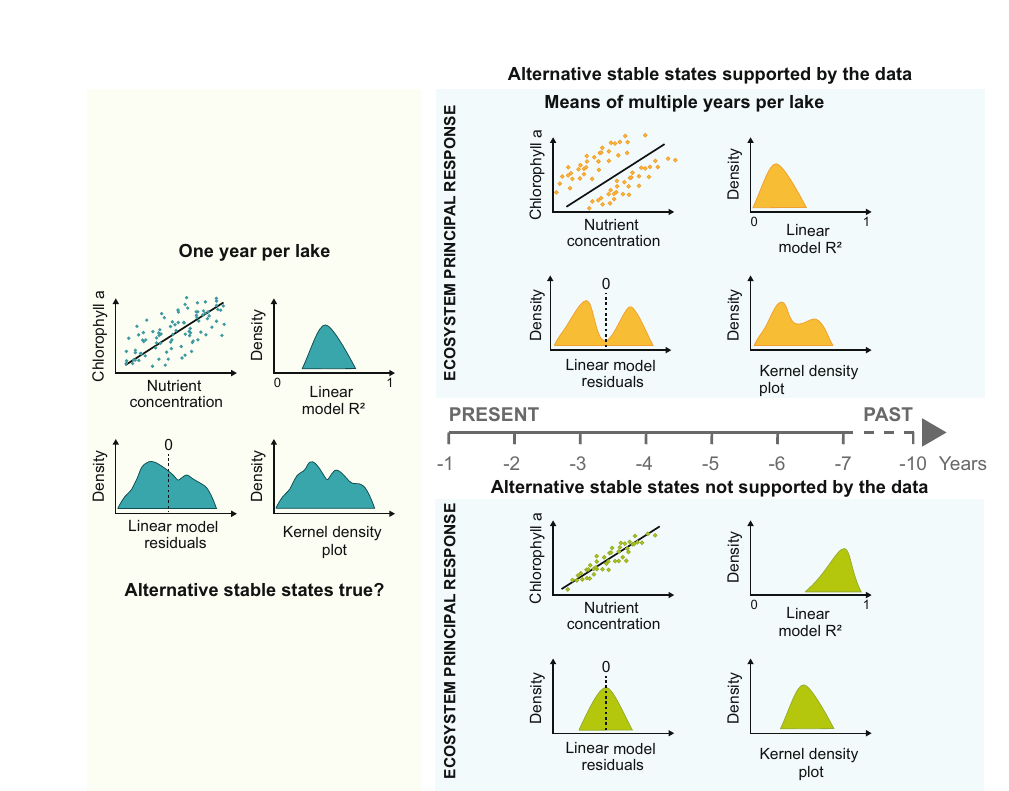
Fig. 1 | Detecting alternative equilibria in spatial data at different temporal scales. The temporal scale increases from a single year on the left to the decadal scale on the right. The data shows typical patterns of nutrient and chlorophyll-a foundinshallowlakesforasingleyear,withresultsofthethreediagnostictests(see methods) applied to detect the presence or absence of alternative stable states (ASS). Single-year data does not provide strong evidence for or against the exis- tenceofASS.In addition to examining the patterns inthe scatter plots of nutrients vs chlorophyll-a, the tests are (i) the R 2 of the model, (ii) the residuals of a linear model of nutrients vs chlorophyll-a, (iii) Kernel density plots of chlorophyll-a data. We present expected patterns (derived from simulations) that would suggest the presence(abovetheline)orabsence(belowtheline)ofASSinshallowlakes.Asthe temporalscaleof theobservationsincreasesfromsingle-yeardatatomultiple-year